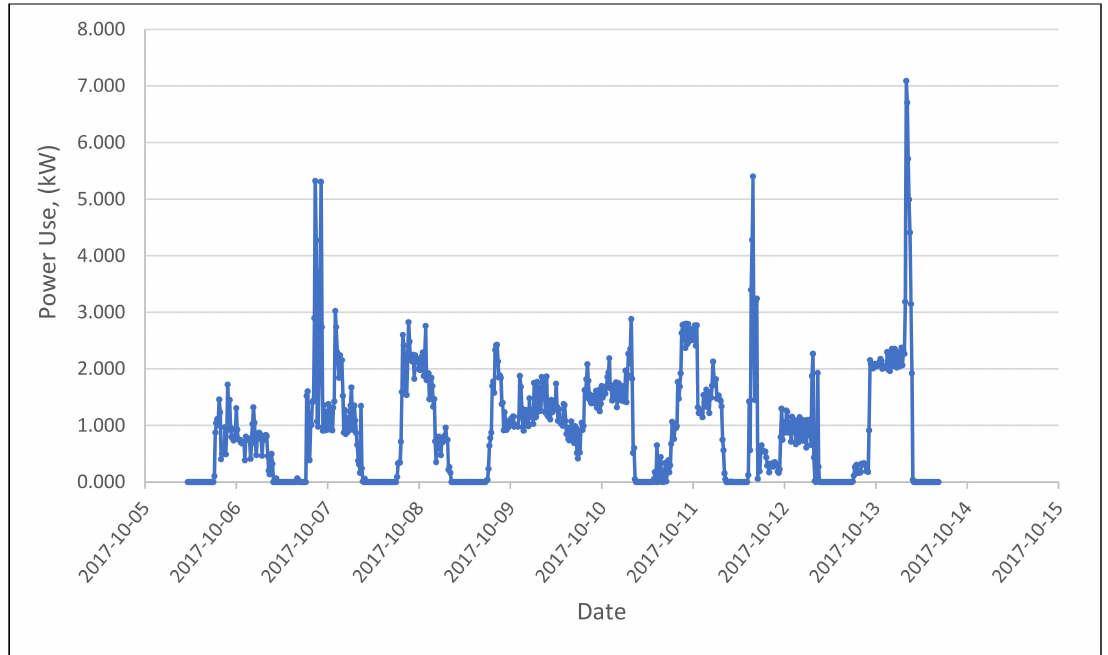
Figure 9. Measured energy consumption by the house at the